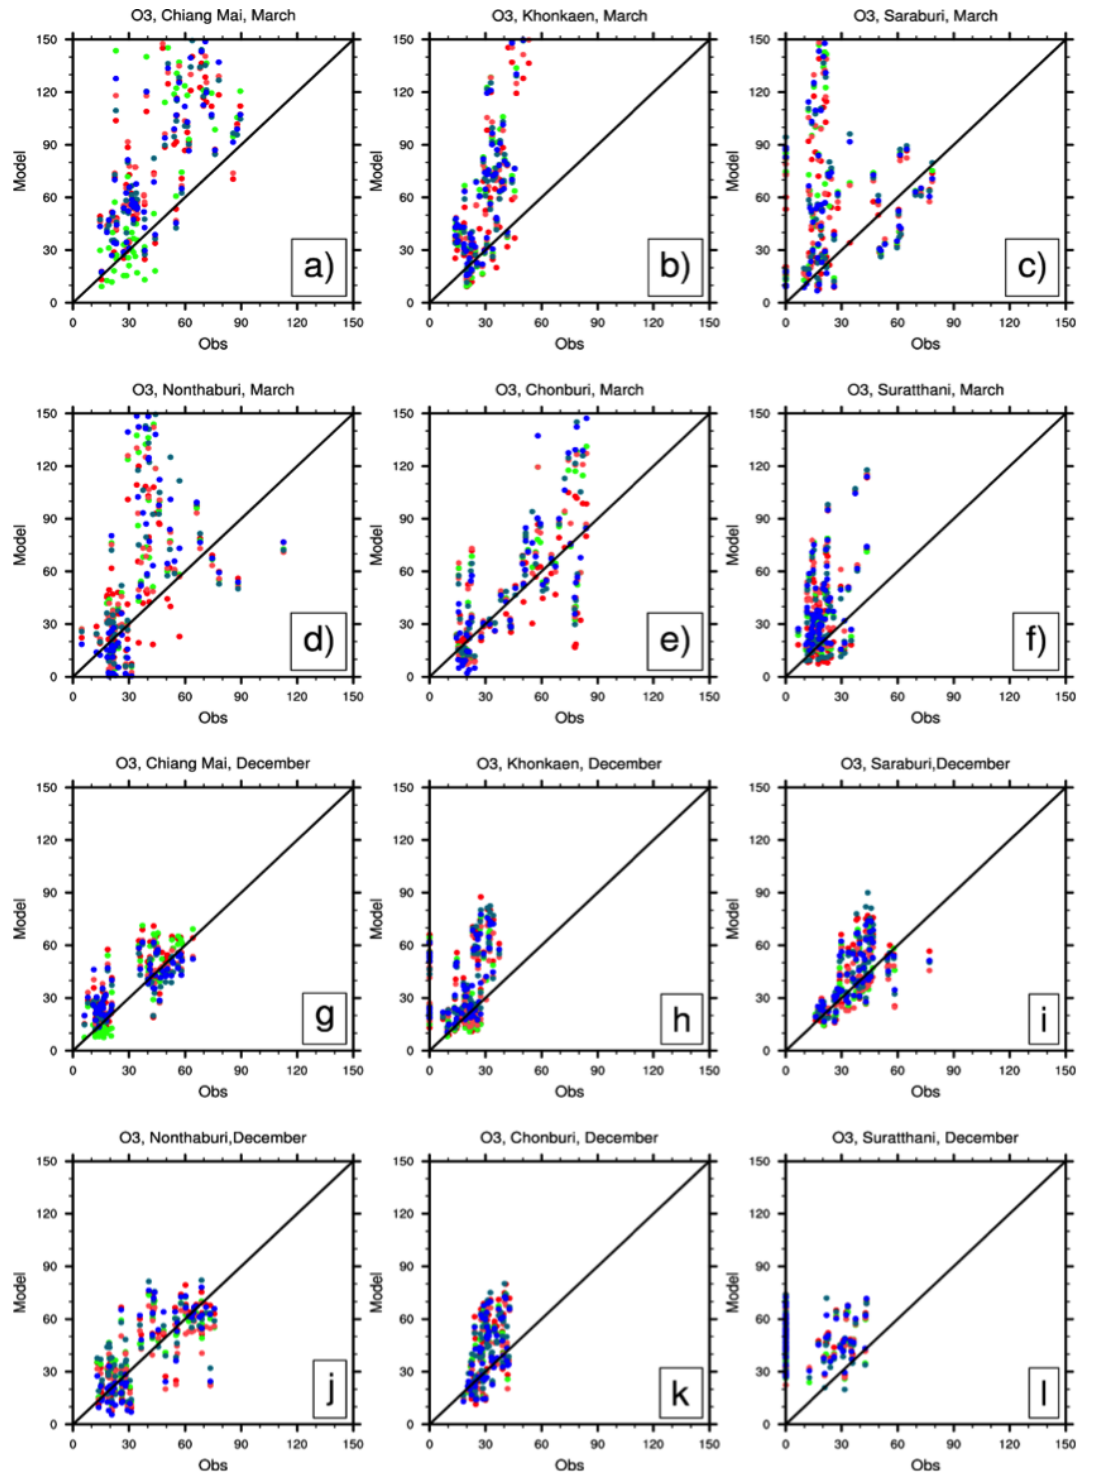
Figure 12. Scatterplots of 6-hourly daytime O 3 from WRF-Chem using different emissions inventories (red dots are RETRO emissions, teal dots are SEAC4RS, orange dots MACCity, green dots INTEX-B, and blue dots are combined MACCity and SEAC4RS) and ground-based observations for March and